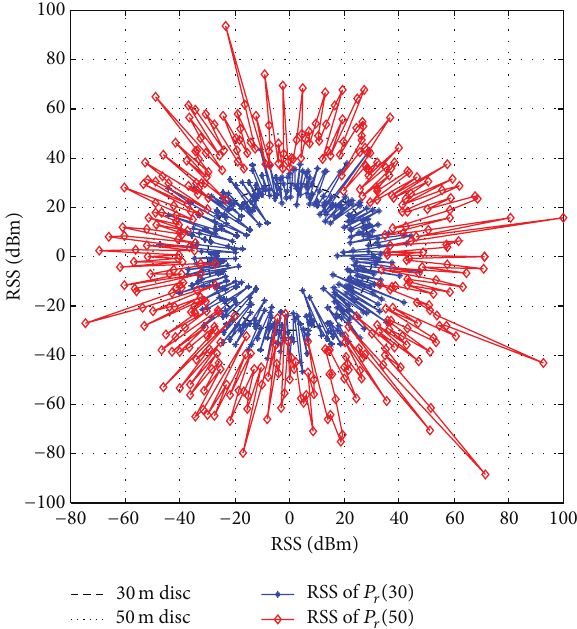
Figure 1: Relationship between RSS and